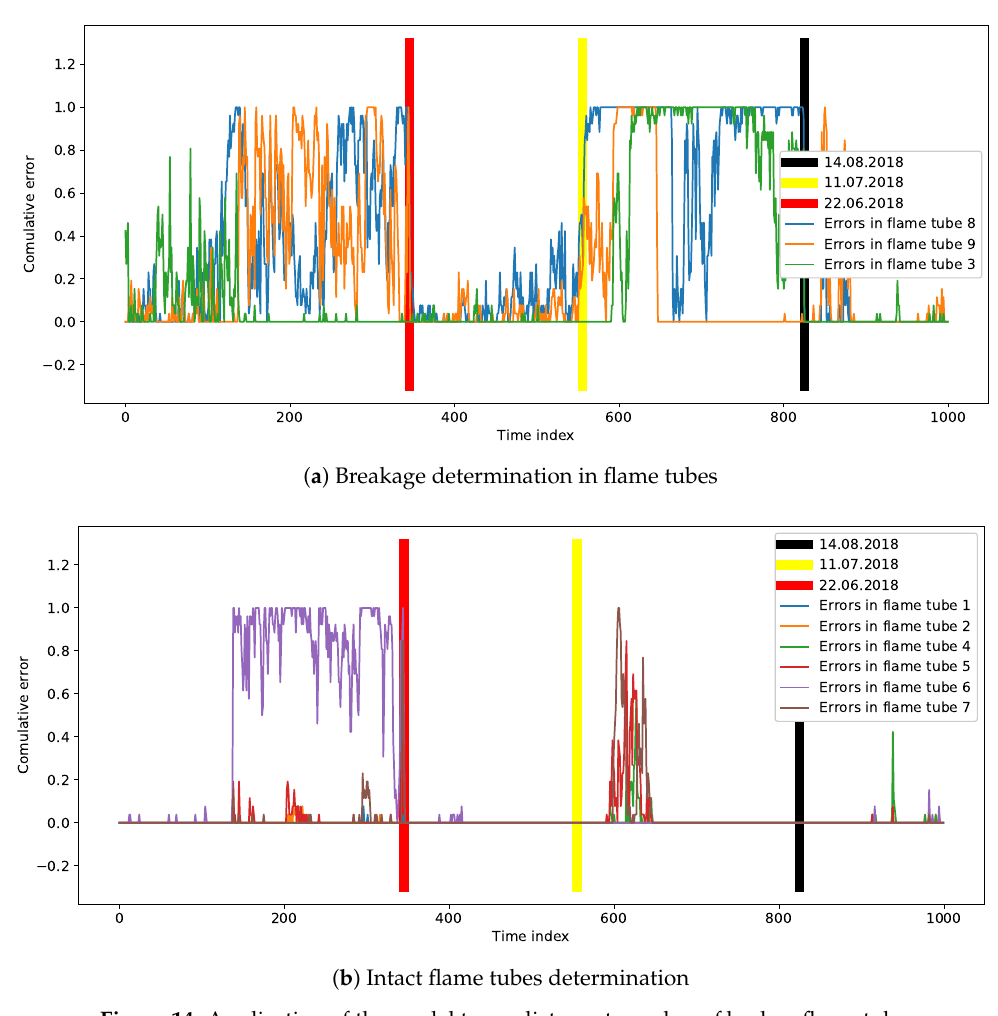
Figure 14. Application of the model to predict exact number of broken flame